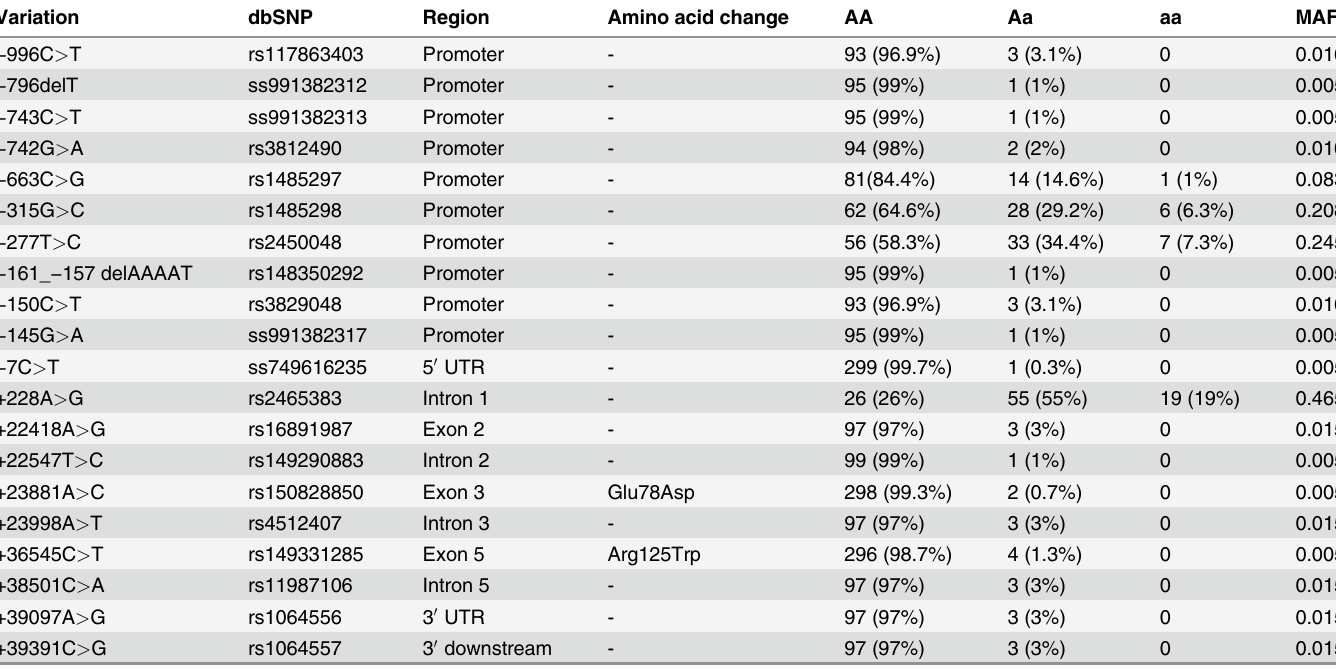
Table 2. Genetic variation observed in the COLEC10 gene.